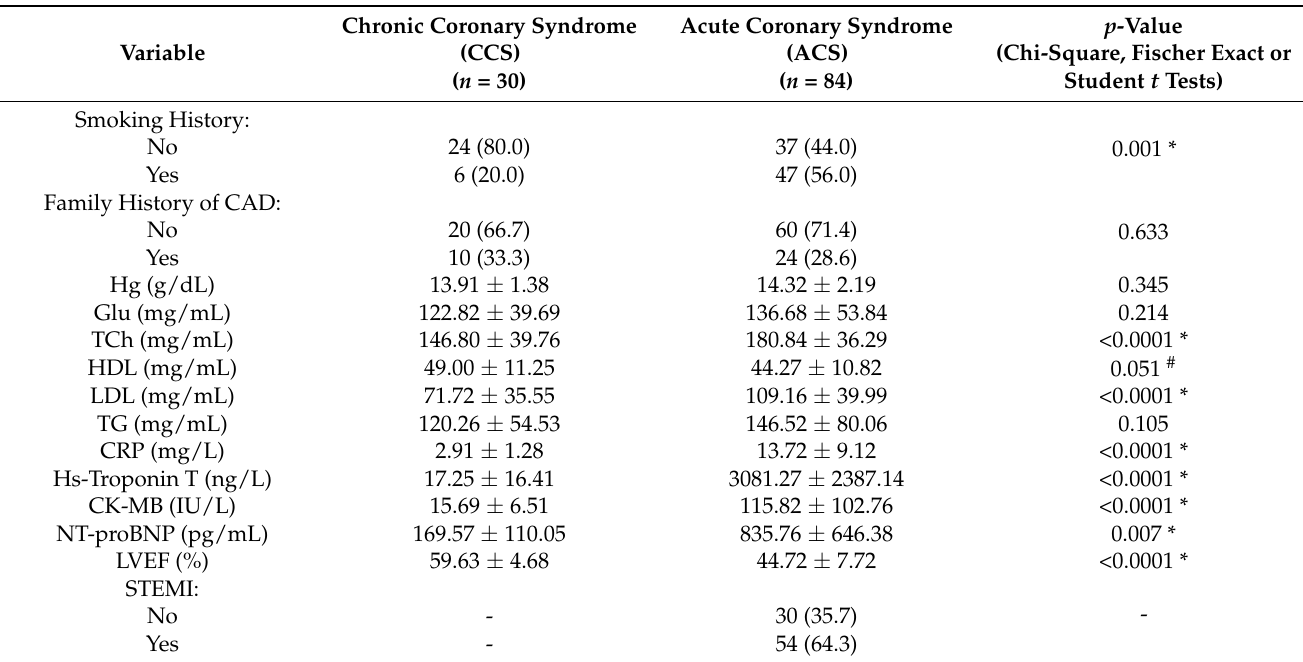
Table 2. Clinical, biochemical and echocardiographic characteristic of patients with chronic and acute coronary syndrome. Descriptive data are presented as number (percentage) or mean ( ±